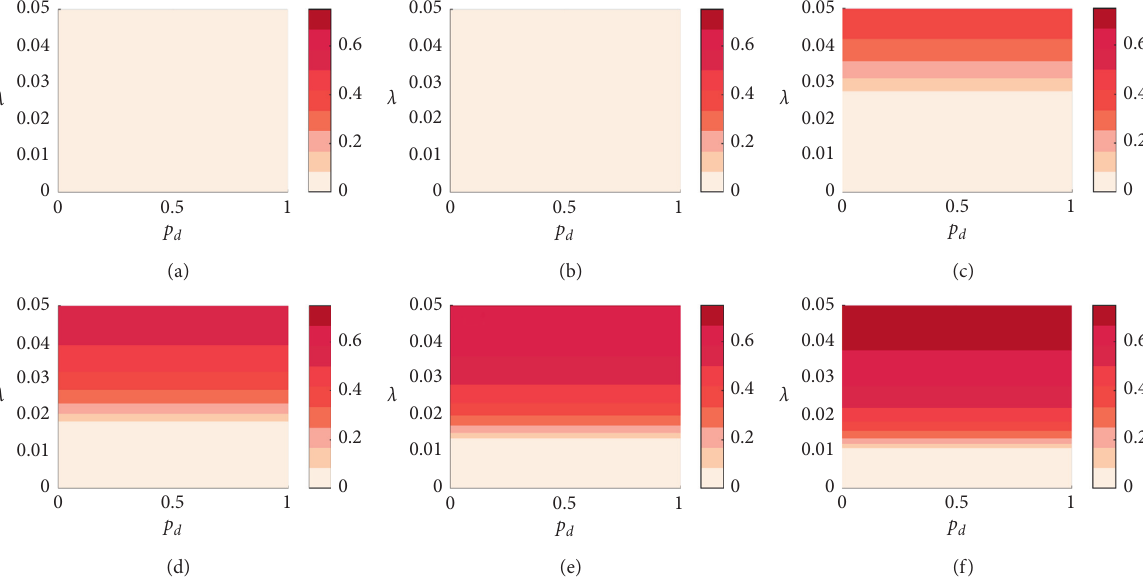
, λ ) plane. The financial risk information spreading size 〈 ρ 〉 as d